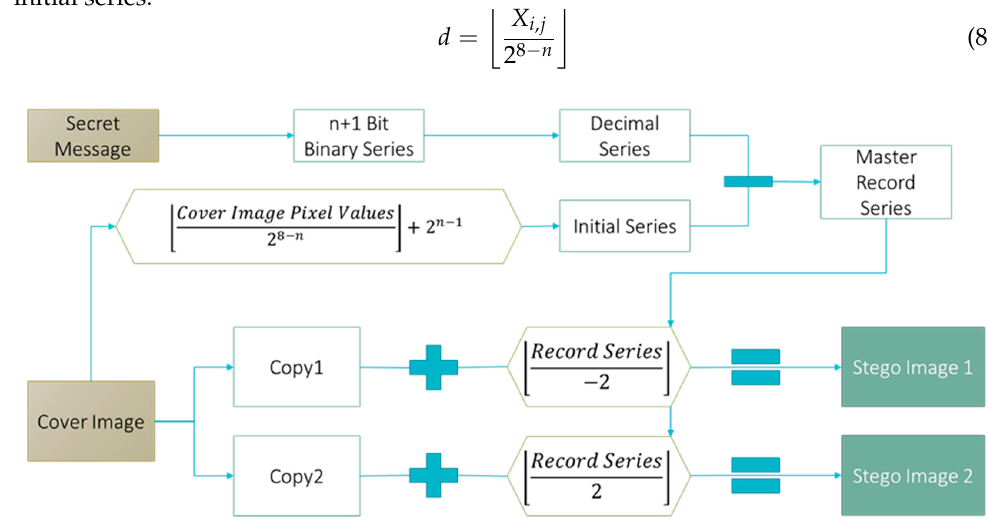
Figure 3. Data hiding process.